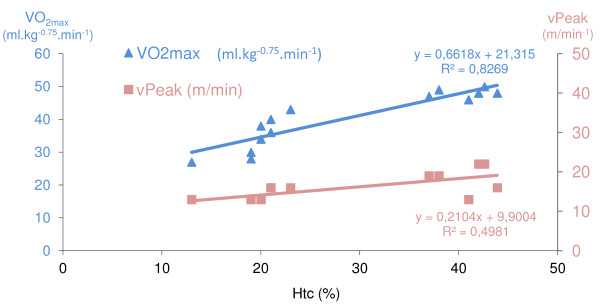
Correlations between hematocrit on one hand and peak velocity and VO2max on the other.